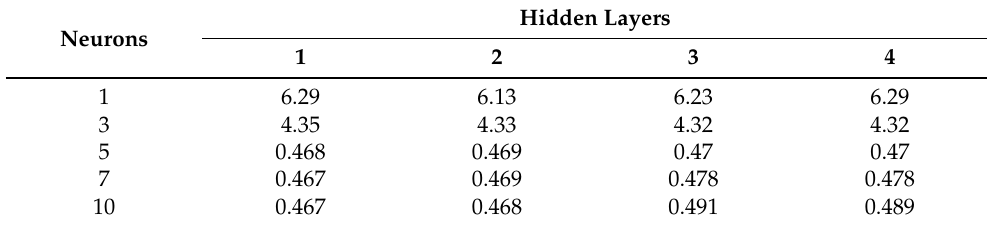
Table 14. CRMSE for imaginary part approximations.